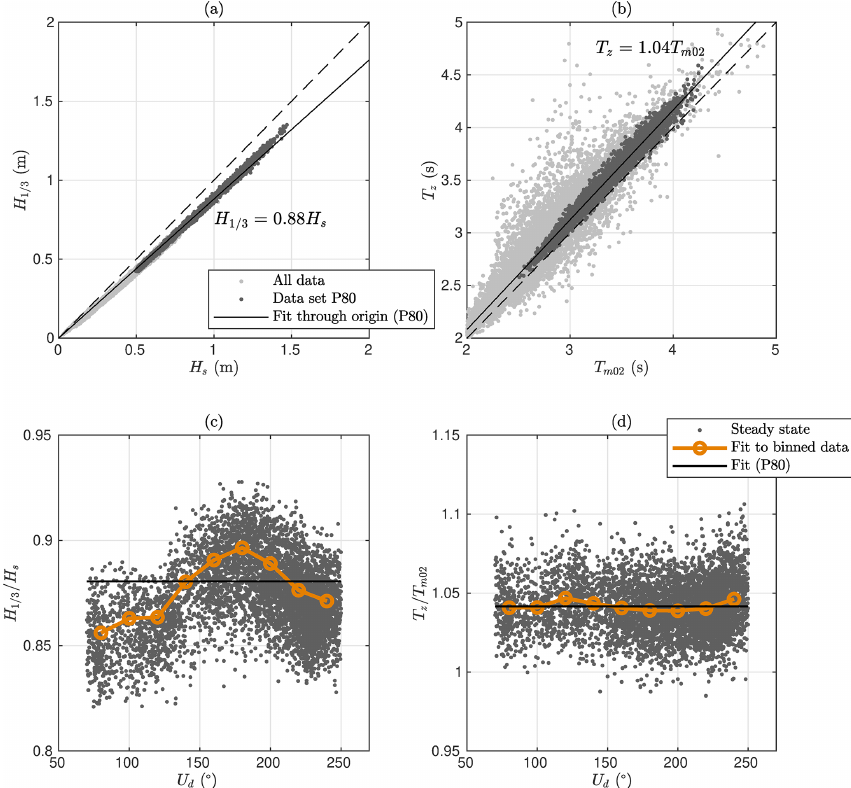
Figure 6. Comparison of H 1 / 3 and T z with respect to H s and T m function of the wind direction.